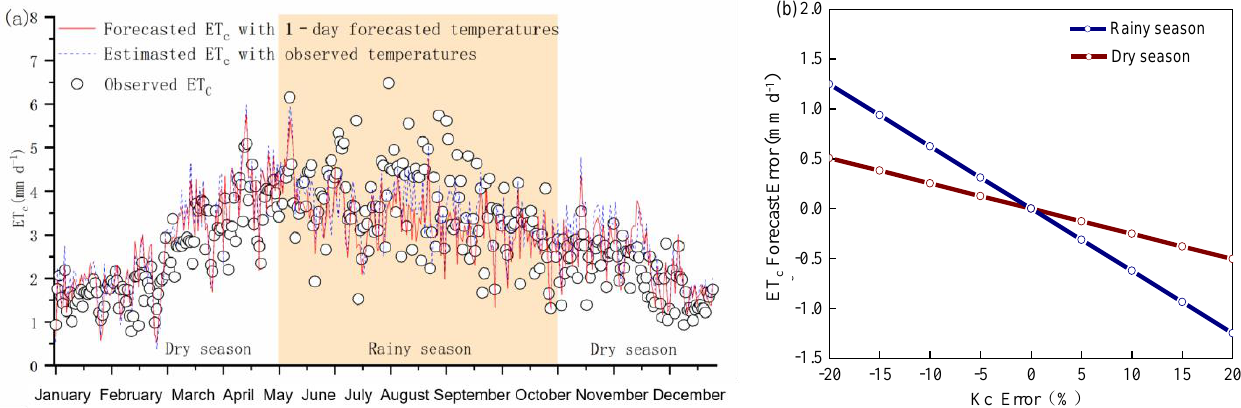
Figure 10. The influence of K c on ET c , for ( a ) comparisons of original K c values and calibrated K c values; ( b ) single factor method on K c error on ET c forecast sensitivity analysis.